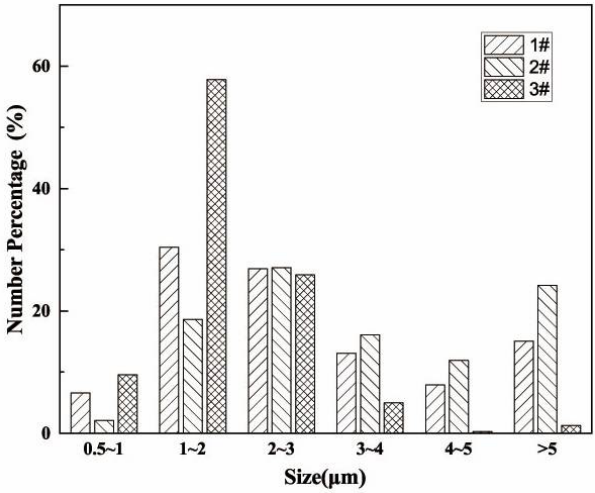
Figure 4. The size distribution of oxides for samples. Table 4. Characteristic parameters of oxides for samples.